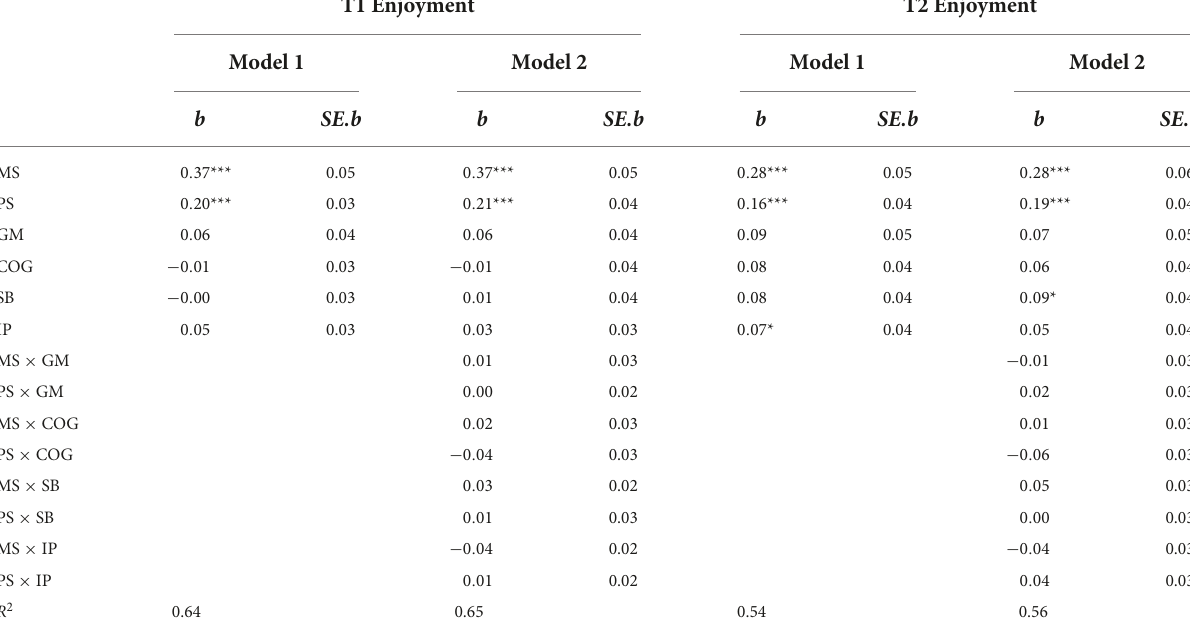
TABLE 4 The main and interaction effects of motivational-regulation strategies and self-regulated writing strategies on writing enjoyment at two time points.